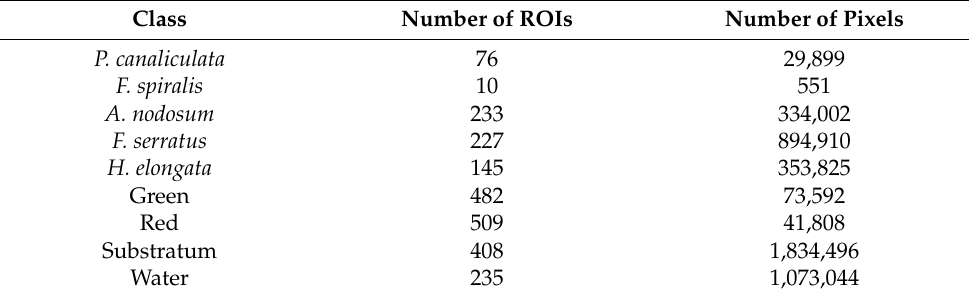
Table 3. Number of ROIs and pixels for each